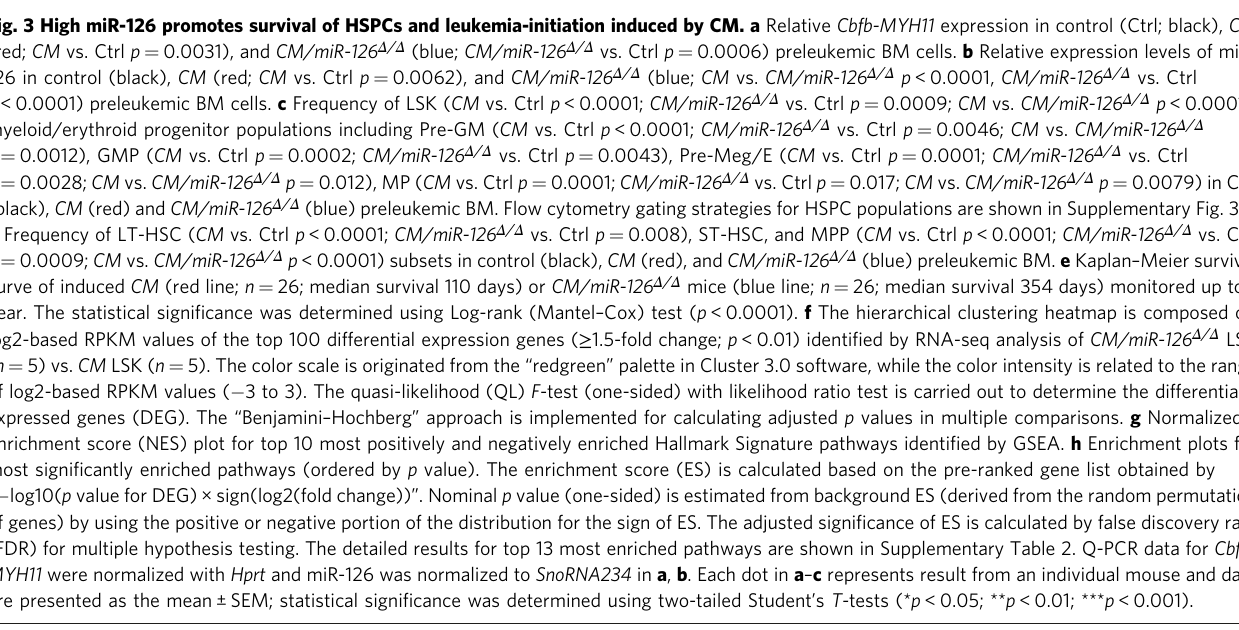
Fig. 3 High miR-126 promotes survival of HSPCs and leukemia-initiation induced by CM. a Relative Cbfb-MYH11 expression in control (Ctrl; black), CM (red; CM vs. Ctrl p = 0.0031), and CM/miR-126 Δ / Δ (blue; CM/miR-126 Δ / Δ vs. Ctrl p = 0.0006) preleukemic BM cells. b Relative expression levels of miR- 126 in control (black), CM (red; CM vs. Ctrl p = 0.0062), and CM/miR-126 Δ / Δ (blue; CM vs. CM/miR-126 Δ / Δ p < 0.0001, CM/miR-126 Δ / Δ vs. Ctrl p < 0.0001) preleukemic BM cells. c Frequency of LSK ( CM vs. Ctrl p < 0.0001; CM/miR-126 Δ / Δ vs. Ctrl p = 0.0009; CM vs. CM/miR-126 Δ / Δ p < 0.0001), myeloid/erythroid progenitor populations including Pre-GM ( CM vs. Ctrl p < 0.0001; CM/miR-126 Δ / Δ vs. Ctrl p = 0.0046; CM vs. CM/miR-126 Δ /